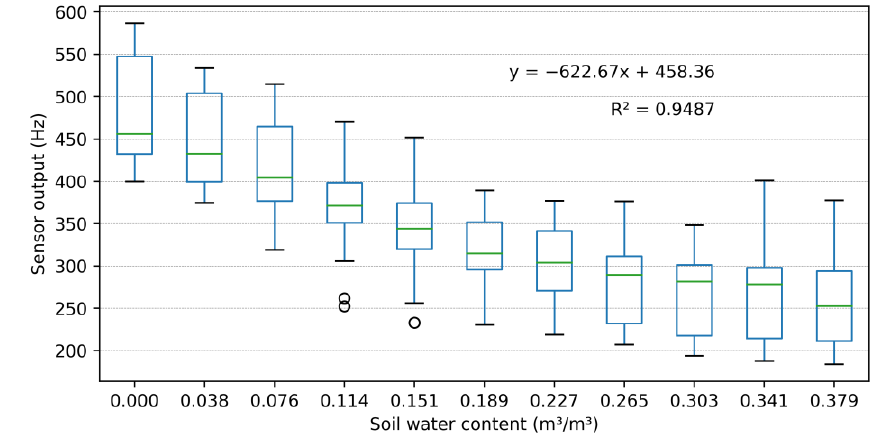
Figure 9. Universal sensor calibration curve. Table 4. Statistical metrics for different calibration methods.